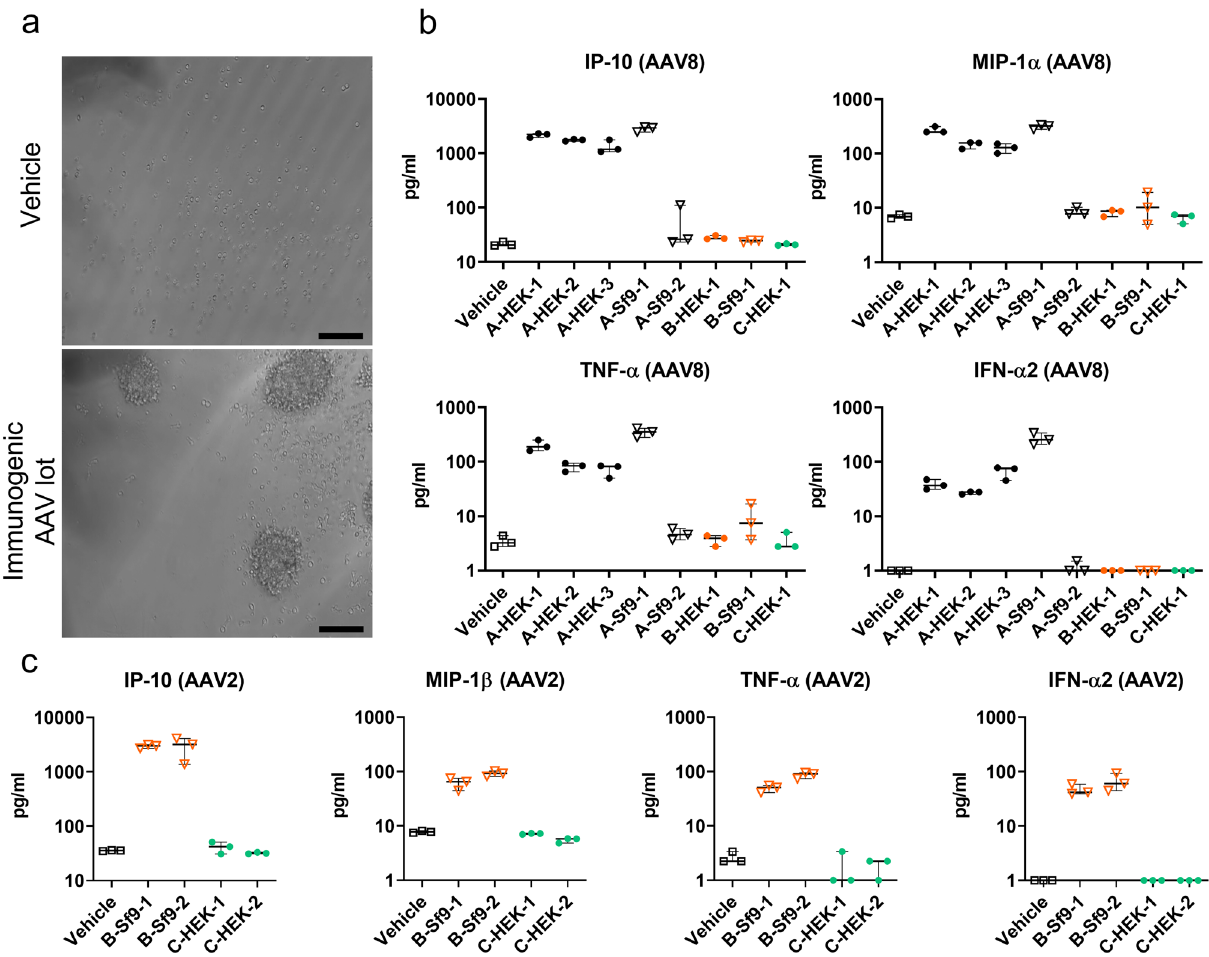
Figure 1. Induction of AAV vector lot-specific immune responses in human pDCs. Human pDCs were stimulated with different lots of AAV8-CMV-eGFP and AAV2-CMV-eGFP (MOI: 1:1 × 10 6 vg) for 18 h ( a ) Representative bright field images of pDCs stimulated with vehicle control (upper image) or an immunogenic AAV vector lot (lower image). Scale bar is 100 μm. ( b ) Cytokine release of IP-10, MIP-1β, TNF-α and IFN-α2 by AAV8-stimulated pDCs. ( C ) Cytokine release by AAV2-stimulated pDCs. Representative plots of one of three to four independent experiments. Since in the IFN-α2 measurements ( b , c ) and TNF-α measurement ( c ) some values fell below the assay range, the constant 1 was added to all measured IFN-α2 and TNF-α values for presentation in a semi-logarithmic plot. Shown are medians and interquartile ranges. In the labels of the individual vector lots the three manufacturers are represented by the letters A, B, C; HEK-cell derived and Sf9-cell derived vectors are indicated by "HEK and "Sf9" and corresponding lots of the same manufacturer and the same production system are numbered “1, 2, 3”. Circle: HEK-derived vector lot; triangle: Sf9 -derived vector lot; black: vector lot from manufacturer A; orange: vector lot from manufacturer B; green: vector lot from manufacturer